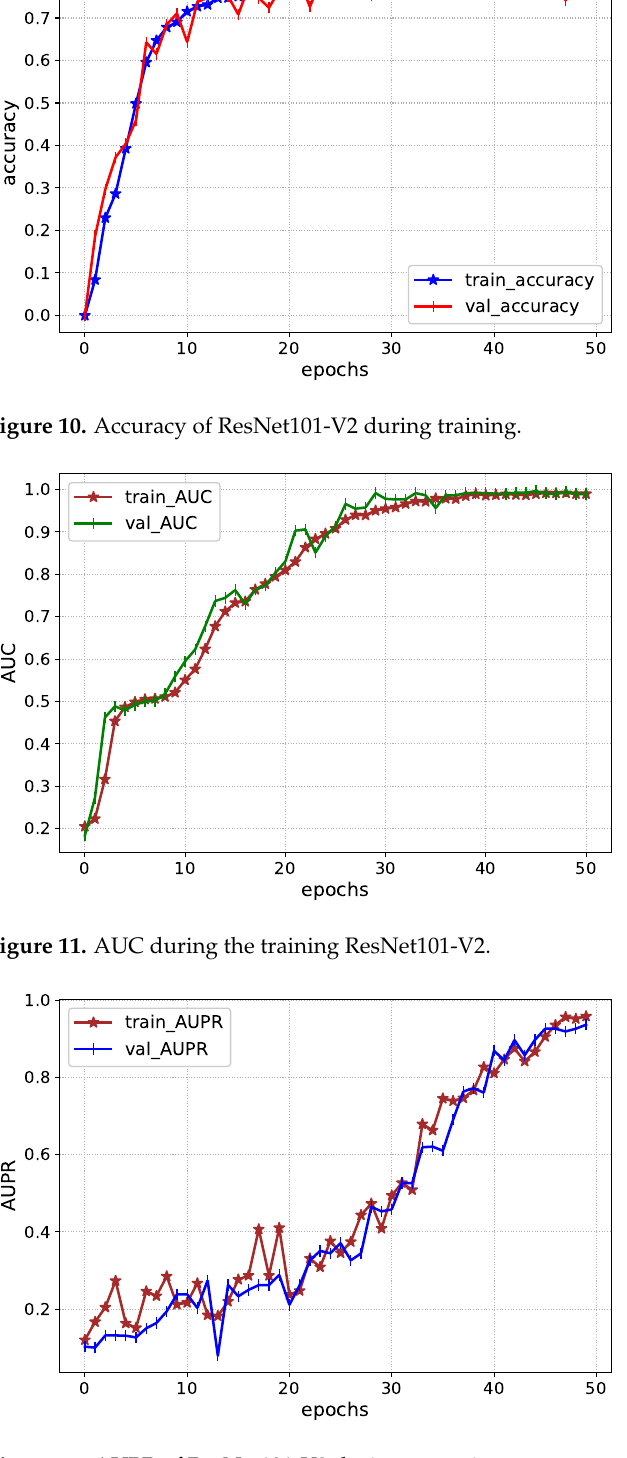
Figure 12. AUPR of ResNet101-V2 during execution. The AUC- and AUPR-based performance of the ResNet101-V2 validates that the employed feature extractor has significant capability to obtain the hidden bleeding regions from intensity-based CT slices. Furthermore, the AUC-based performance of the proposed solution in terms of the receiver operating characteristics (ROC) curve is shown in Figure 13. The ROC curves depict the TPR versus FPR to demonstrate the ICH detection and